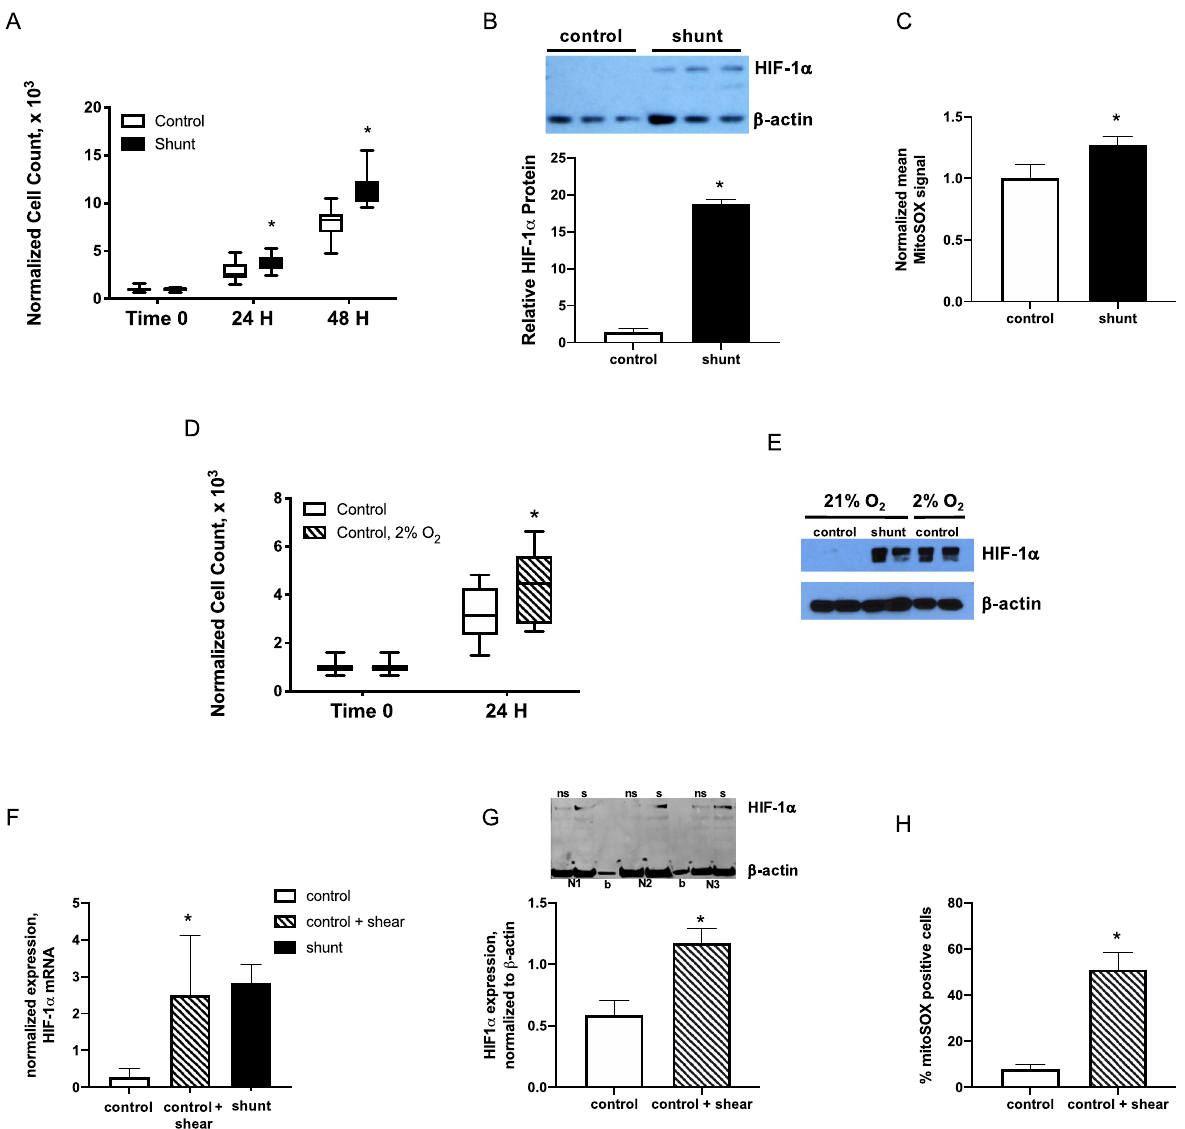
Figure 3. Stabilization of HIF-1α is associated with faster LEC growth and accumulation of mitochondrially- derived reactive oxygen species (ROS). ( A ) shunt LECs proliferate with doubling time 15.2% faster than control LECs, *, P < 0.05, N = 3 control, 3 shunt, and ( B ) have 13.1-fold higher expression of HIF-1α, P < 0.05, N = 3 control, 3 shunt. NB, bar graph represents HIF-1α protein normalized to β-actin. ( C ) Mitochondrially-derived ROS were increased 1.3-fold in shunt LECs compared to controls, P < 0.05. N = 5 control, 5 shunt. NB, bars represent MitoSOX signal normalized to control. ( D ) control LECs cultured in 2% O 2 proliferate significantly faster than control LECs cultured in 21% O 2 , *, P < 0.05; N = 3 control + 21% O 2 , 3 control + 2% O 2 . ( E ) HIF-1α is stabilized in control LECs cultured in 2% O 2 . ( F – H ) In control LECs exposed to 0.9 N/m 2 of shear for 24hrs using a parallel plate flow chamber (ibidi Pump System), ( F ) expression of HIF-1α mRNA is significantly increased compared to levels in non-sheared control LECs, *, P < 0.05, N = 3 control no shear, 3 control + shear, 3 shunt; ( G ) similarly, HIF-1α protein is significantly stabilized in sheared (s) control LECs compared with non- sheared (ns) controls, *, P < 0.05; N = 3 control no shear, 3 control + shear; and, ( H ) 51% ± 8% sheared control LECs stained positive with MitoSOX compared with 8% ± 2% in non-sheared control LECs, *, P < 0.05; N = 3 control no shear, 3 control + shear. In panel F, blank lanes marked by ‘b’. In panels A, B, D, F, G, and H, error bars represent standard deviation. For panels B, E, and G, full-length blots/gels are presented in Supplemental Fig.